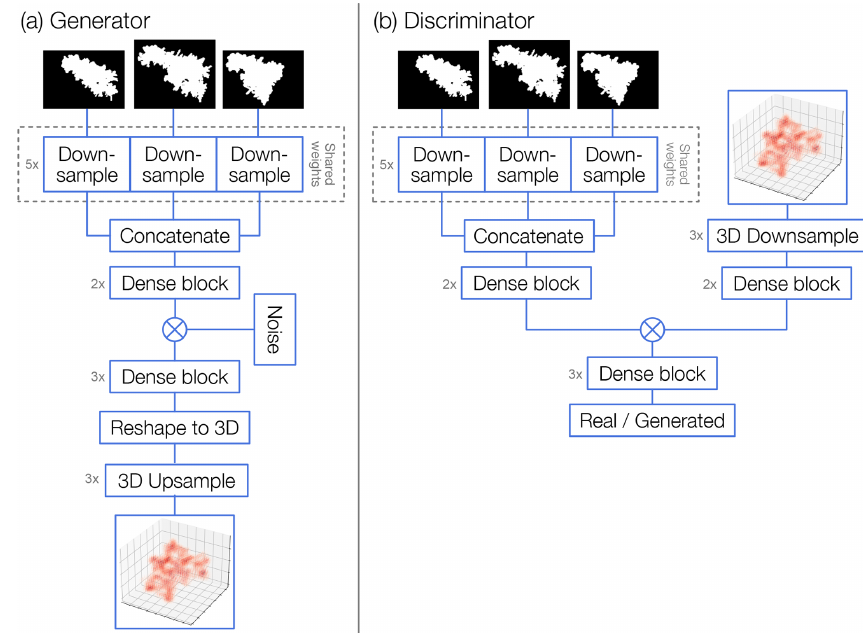
Figure 1. Illustration of the architectures of the (a) generator and (b) discriminator of the